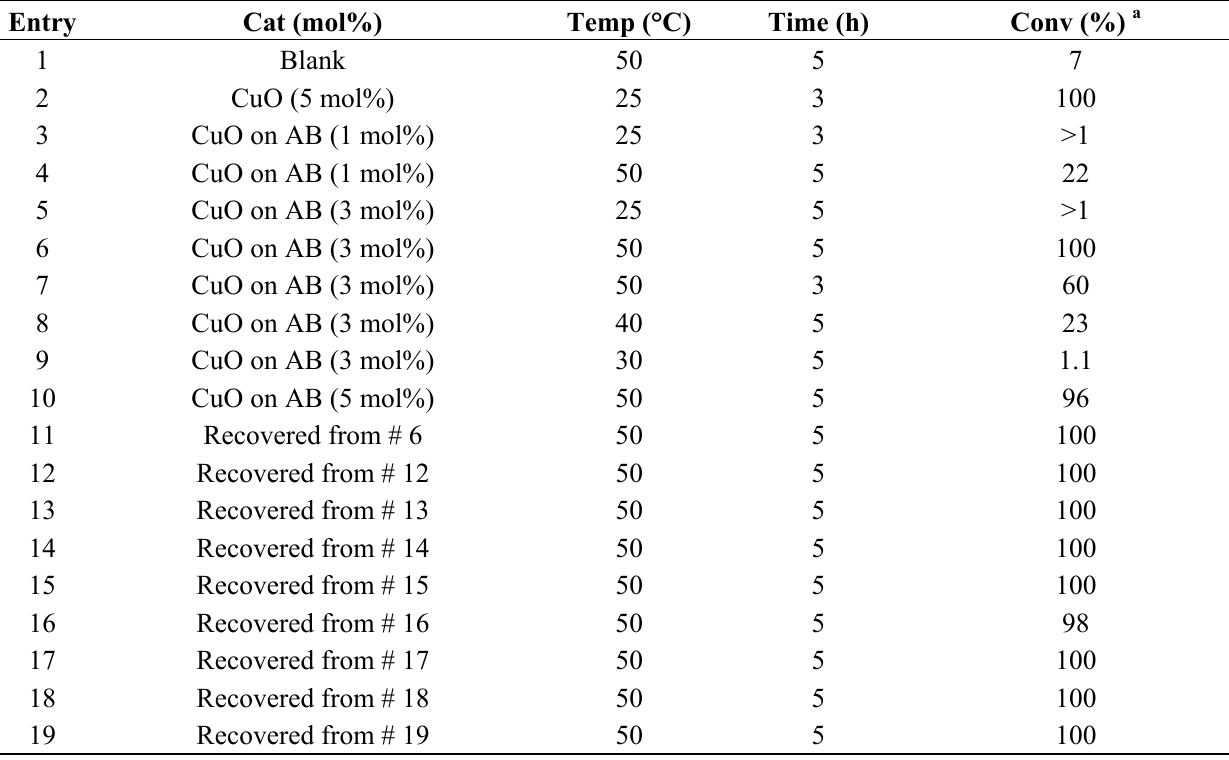
Table 2. Optimization of click reaction catalyzed by various CuO